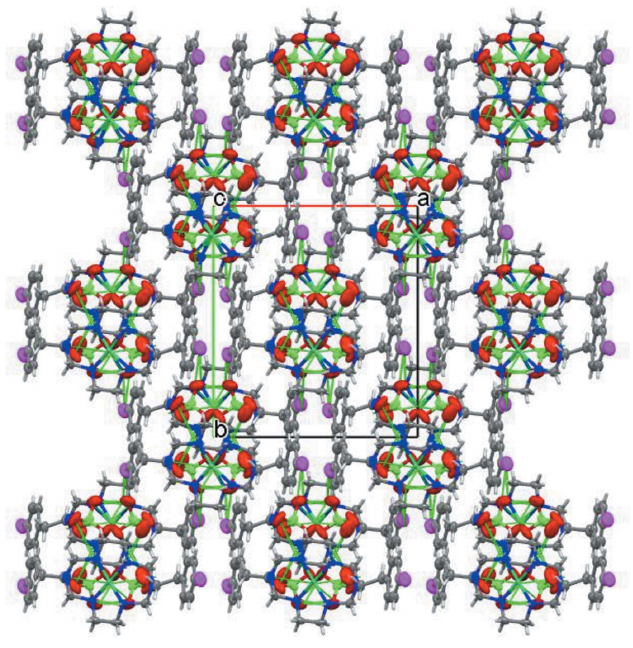
Figure 4 Aview of the crystal packing of [Ni L ](ClO 4 ) 2 , which resembles a seamless floral lace pattern. Light-green dashed lines indicate hydrogen-bonding